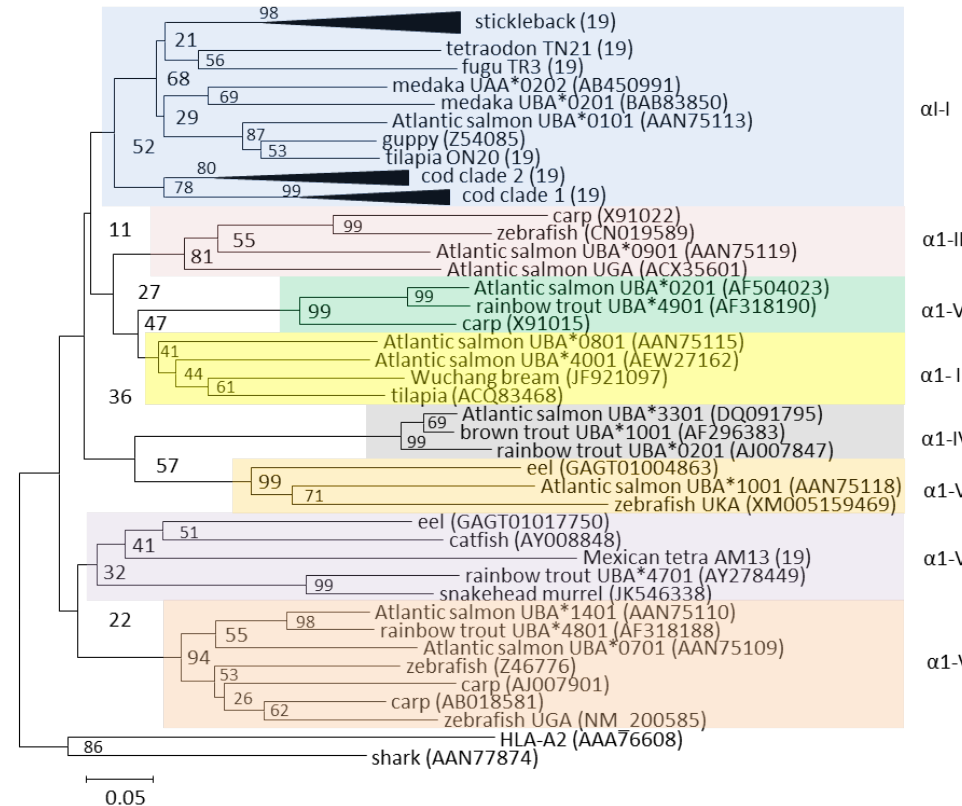
Figure 2. Phylogeny of selected U lineage alpha 1 domain amino acid sequences from Grimholt et al. [19]. The eight U lineage alpha 1 domain lineages are shown as shaded boxes with Roman numbers outside each lineage cluster. The black triangles shown for stickleback and the two cod clades are collapsed clusters of 25 and 10 sequences each, respectively. GenBank sequence references are shown using parentheses, while the remaining sequences and sequence references can be found in [19]. The tree is made using Neighbor-joining P-distance and pairwise deletions. The tree is drawn to scale, with branch lengths representing the number of amino acid substitutions per site (see scale bar). Bootstrap values in percentage from 1000 trials are shown. The tree is rooted using the human HLA-A2 and shark